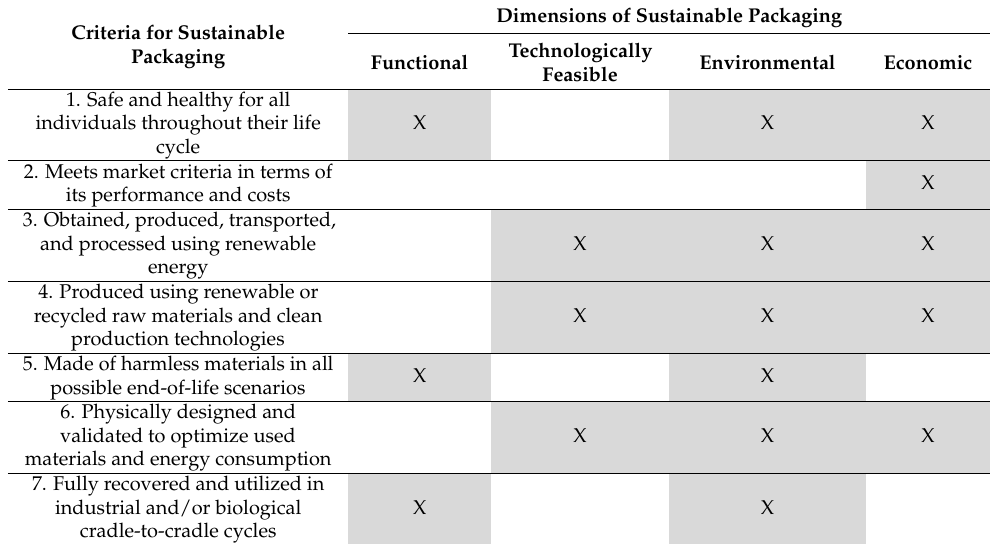
Table 4. Matrix of criteria and dimensions of the sustainable packaging. Criteria for Sustainable